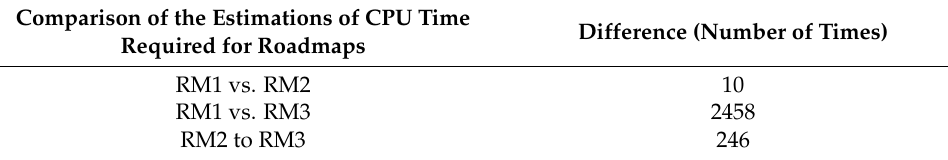
Difference (Number of Times)